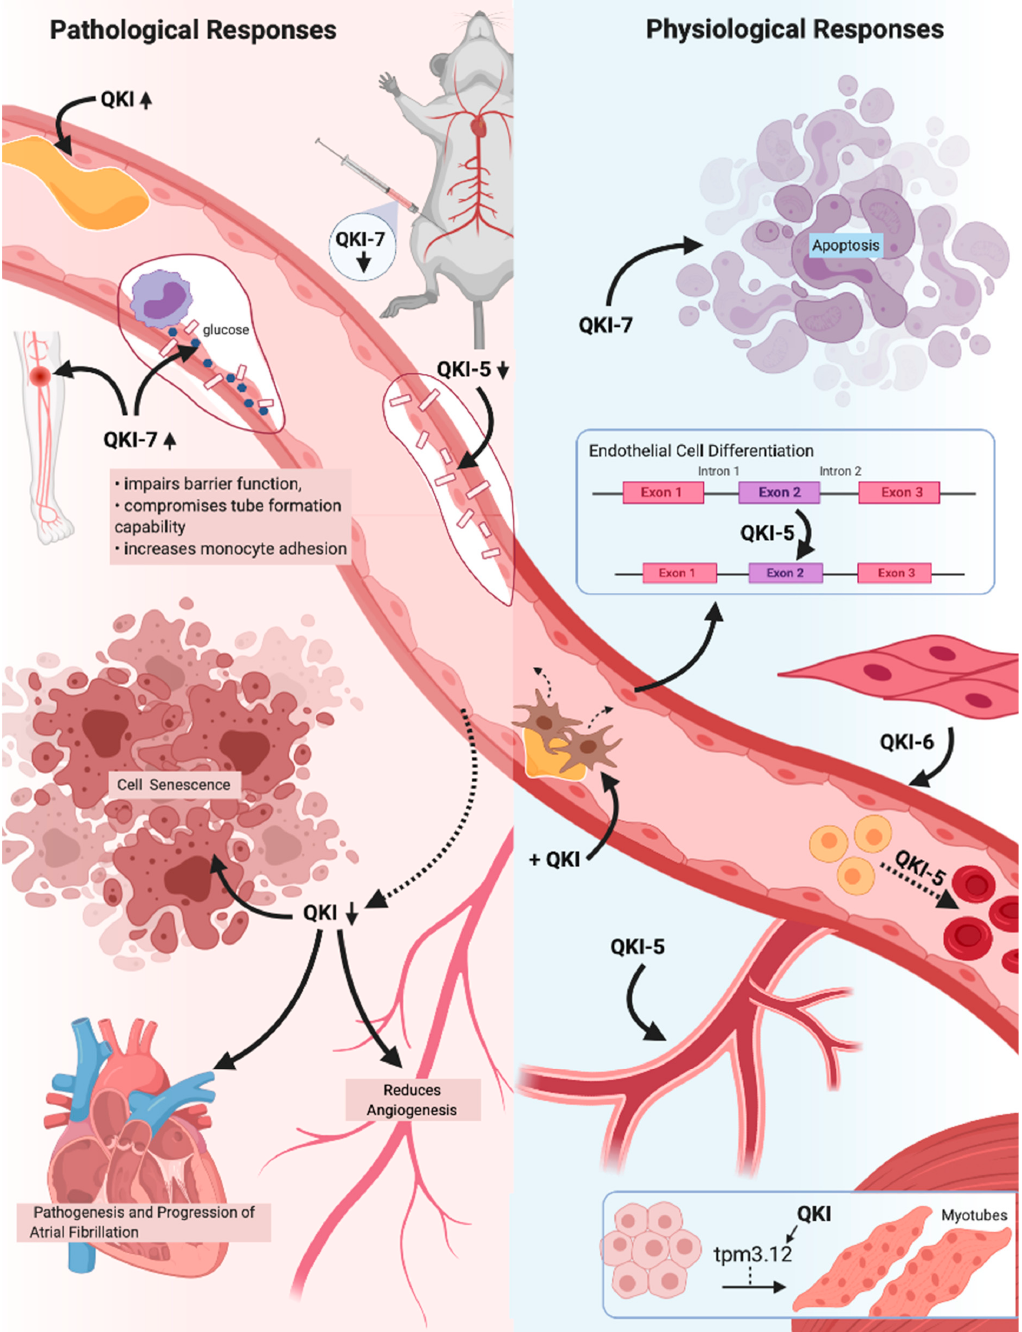
Figure 3. A schematic overview of the critical pathological and physiological responses the (car- dio)vascular system exhibits in response to the three major Quaking (QKI) isoforms. QKI expression is known to drastically increase in response to vascular injury, suggesting reparative roles of the QKI isoforms. QKI reduction results in an inhibition of angiogenic and proliferative capabilities, as well as promotes cell senescence. Reduction in atrial myocytes specifically results in atrial fibrillation, whilst a lack of QKI-5 in endothelial cells (ECs) greatly impairs cell-to-cell adhesions and barrier function. QKI expression has also been shown to be vital in numerous cellular processes, including